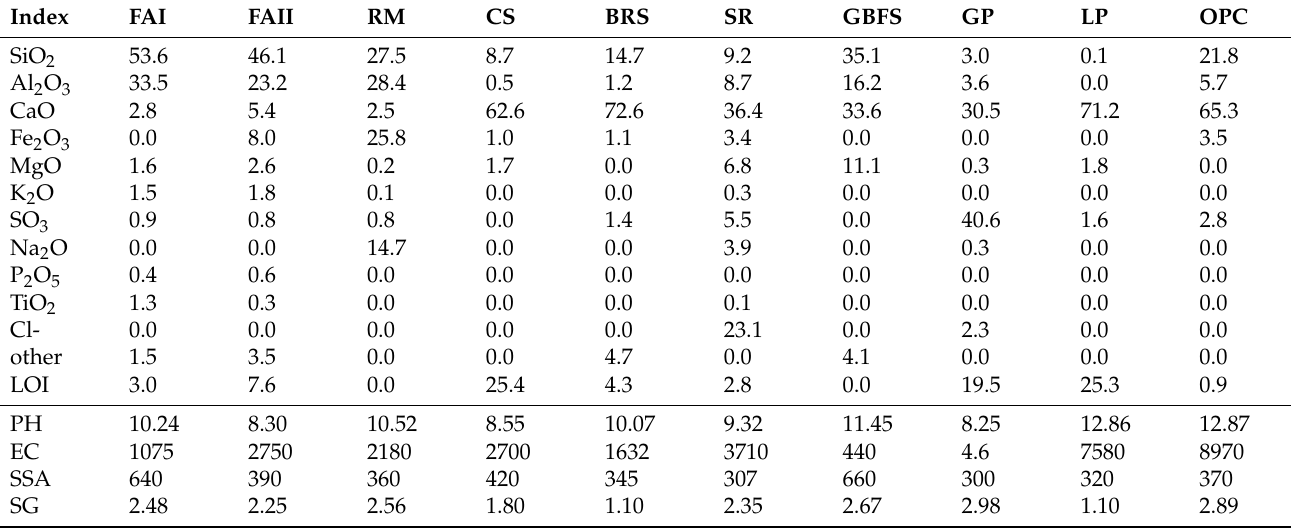
Table 1. The chemical compositions of raw materials measured by XRF test (mass %). LOI refers to the loss on ignition at 1000 ◦